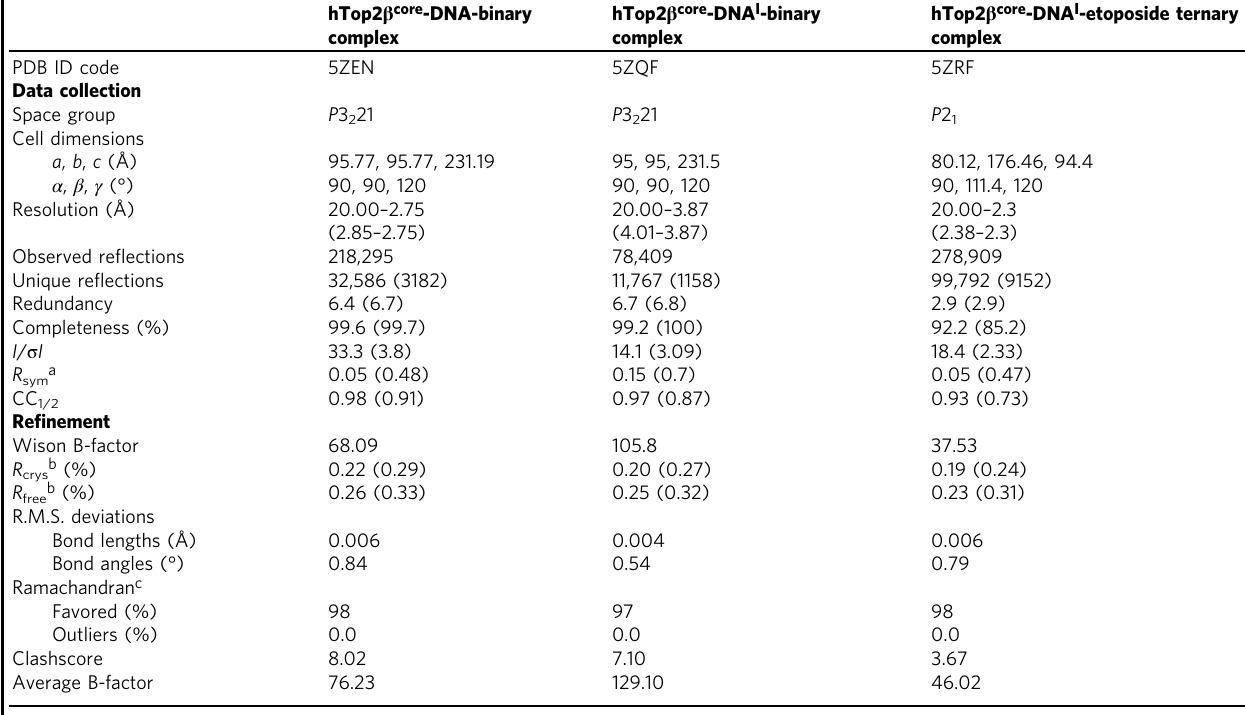
Table 1 Data collection and re fi nement statistics hTop2 β core